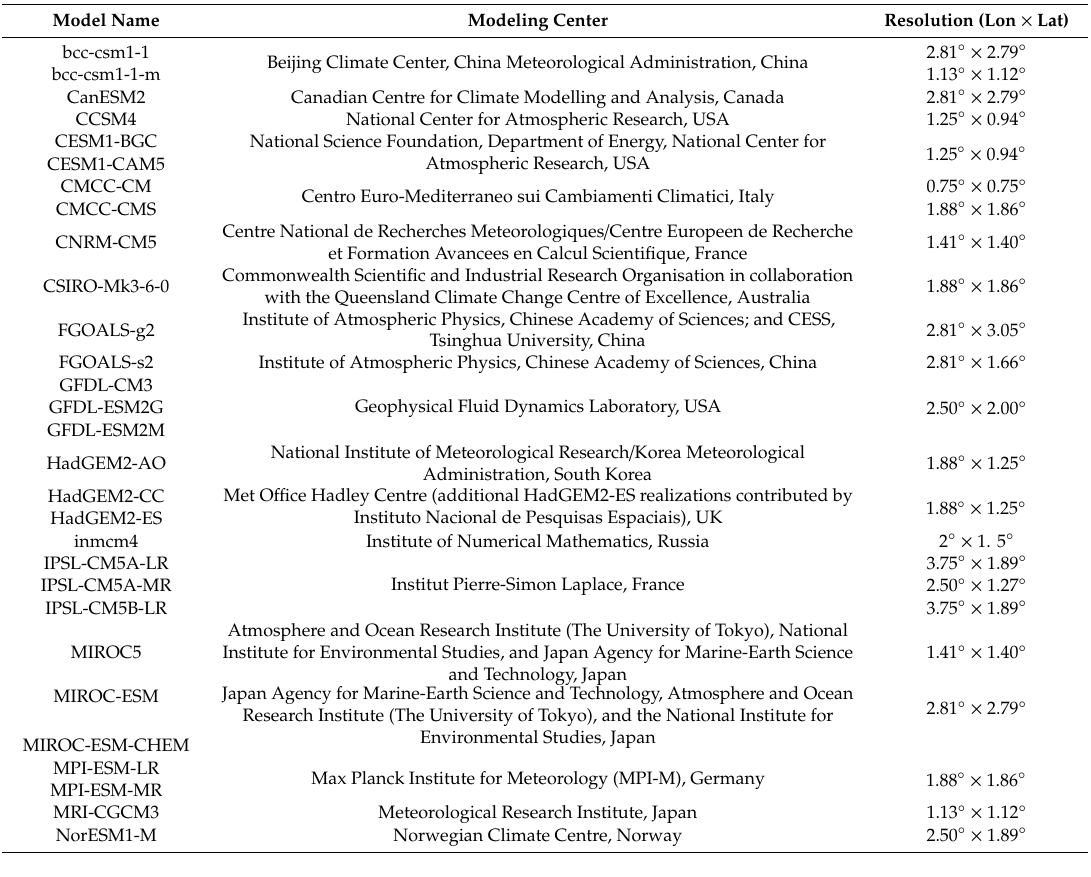
Table 3. Summary of Coupled Model Intercomparison Projects (CMIP)5 climate models used in this